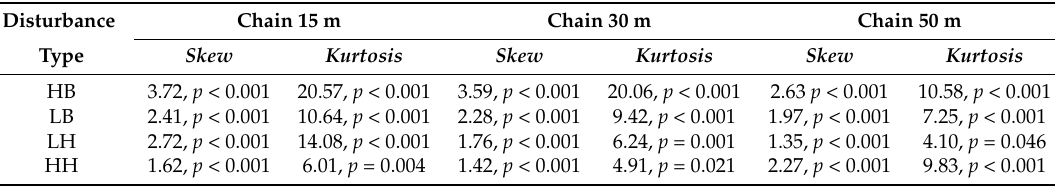
Table 1. Results of statistical tests of skewness and kurtosis for the distribution of group size data from different disturbance types. Estimates and p -values are provided for each disturbance type expressed as abbreviation; HB (High Benign), LB (Low Benign), LH (Low Harm), and HH (High Harm) across chain-rules (15 m, 30 m, and 50